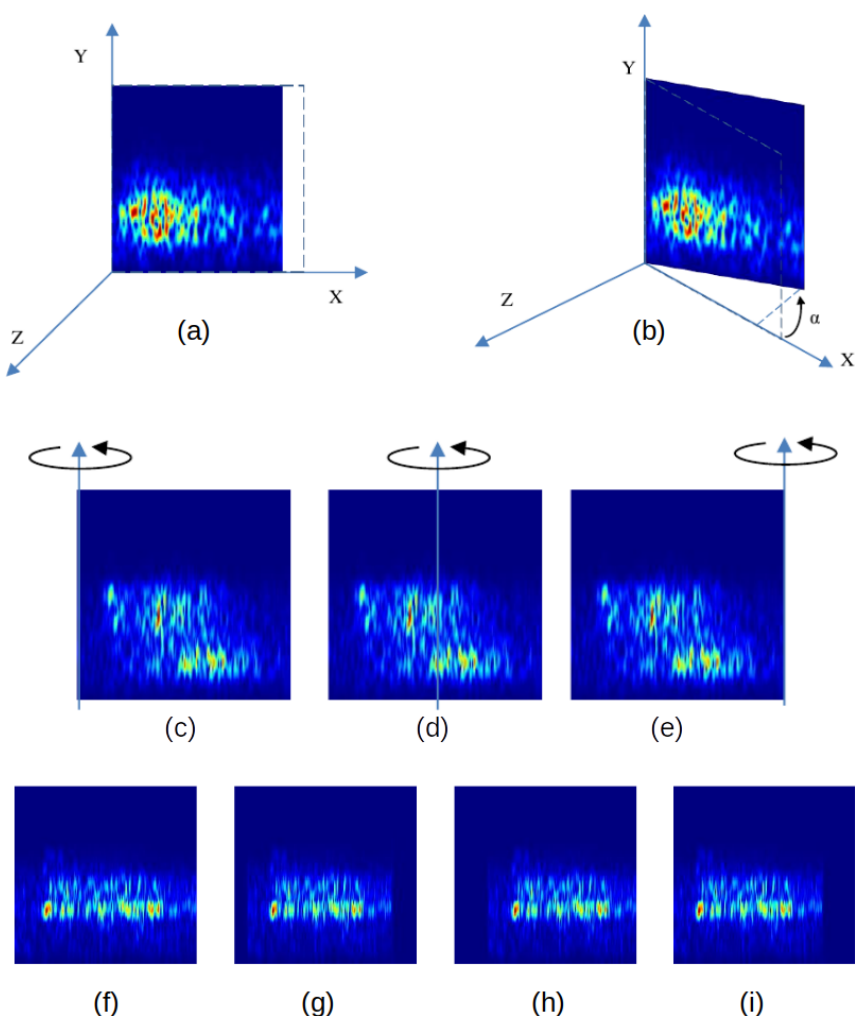
Figure 6. Transformation by rotations, the time stretching (a) is produced when we change the angle of rotation α around the frequency axis (b) ; examples of the tree possibilities of rotations, around a left (c) , central (d) , and right axis (e) , respectively; examples of how the time stretching is produced by rotations, (f) original spectrogram, (g) rotation of 19% around the central axis, (h) rotation of 23% around a right axis, and (i) rotation of 24% around a left axis.